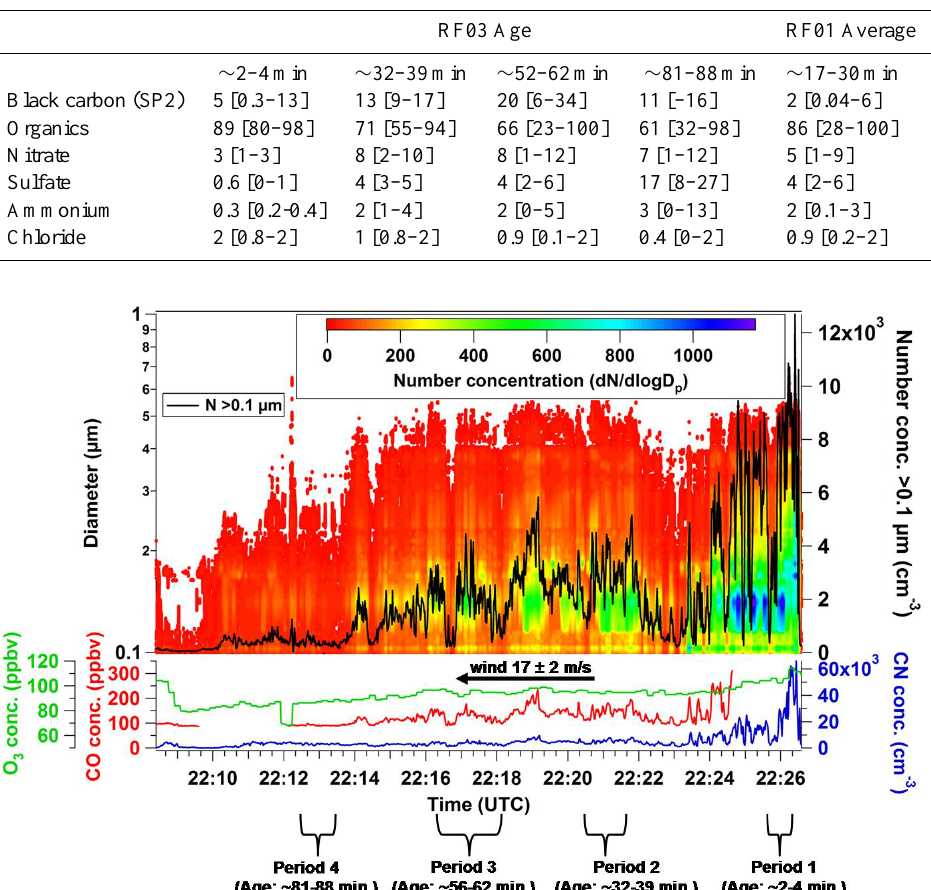
Fig. 2. RF03 temporal profiles of UHSAS size-resolved particle number concentrations are illustrated with associated concentrations of CO, O 3 , CN, and particles > 0.1µm. Since CO data are not available for sampling closest to the burn source, maximum concentrations are estimated to be greater than the highest measured value of 311ppbv, well above the average background air concentration of 92.6 ± 0.9ppbv. The aircraft was flying into the wind, as indicated by the arrow; therefore, later sampling times correspond to sampling closer to the fire source. Discussed time periods and calculated smoke plume ages are